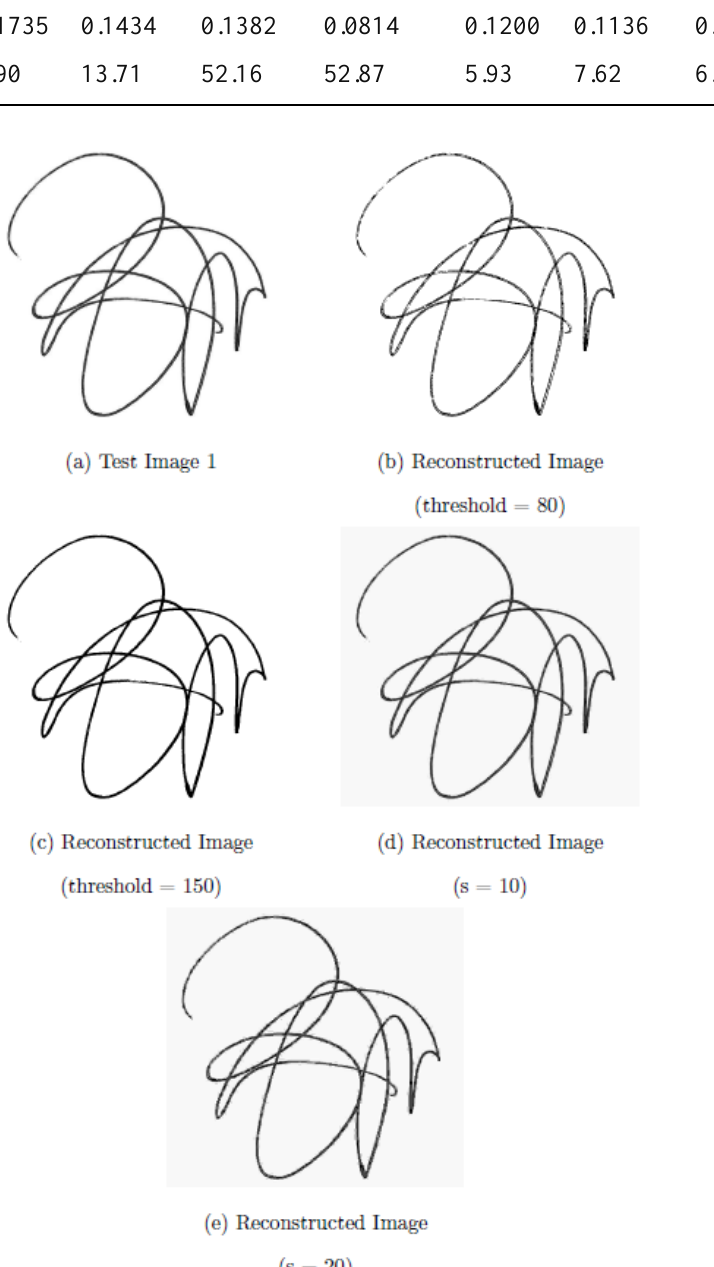
Figure 5. Outputs of the two codecs for test image